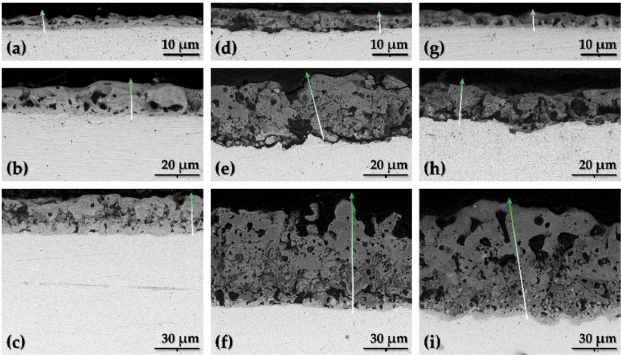
Figure 2. SEM cross-sectional images of the PEO oxide coatings on Ta substrate obtained from the solutions: Ca1P2 ( a – c ), Ca5P3 ( d – f ) and (CaMg)5P3 ( g – i ); and treated up to the limiting